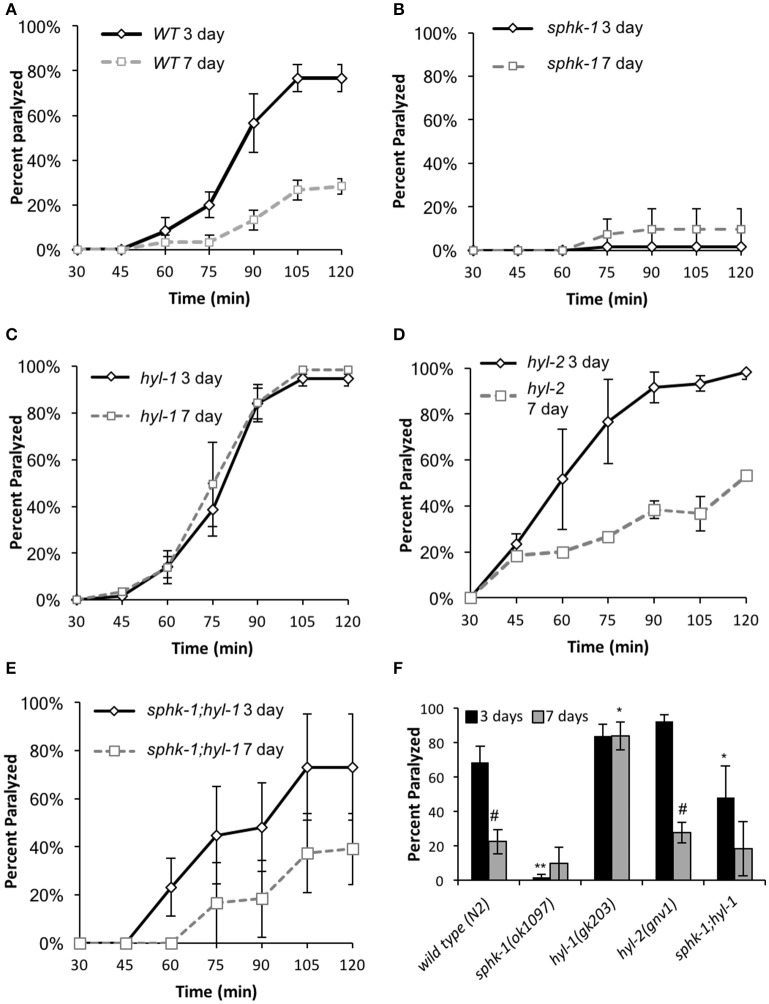
Sphingolipid enzymes regulate neuromuscular function. (A–E) Age-dependent changes in paralysis response of 3-day and 7 day old wild type animals to aldicarb (1 mM) exposure in the indicated strains. (F) Percent of animals paralyzed for the indicated strains after 90-min of aldicarb exposure. For all experiments, animals were examined 3 or 7 days post-hatching, and were transferred onto NGM plates containing aldicarb for testing. For all, error bars are ± SEM and are performed in triplicates; *p < 0.01 and **p < 0.001 for comparisons to the wild type counterpart and #p < 0.01 for comparisons to the 3 day old counterpart.